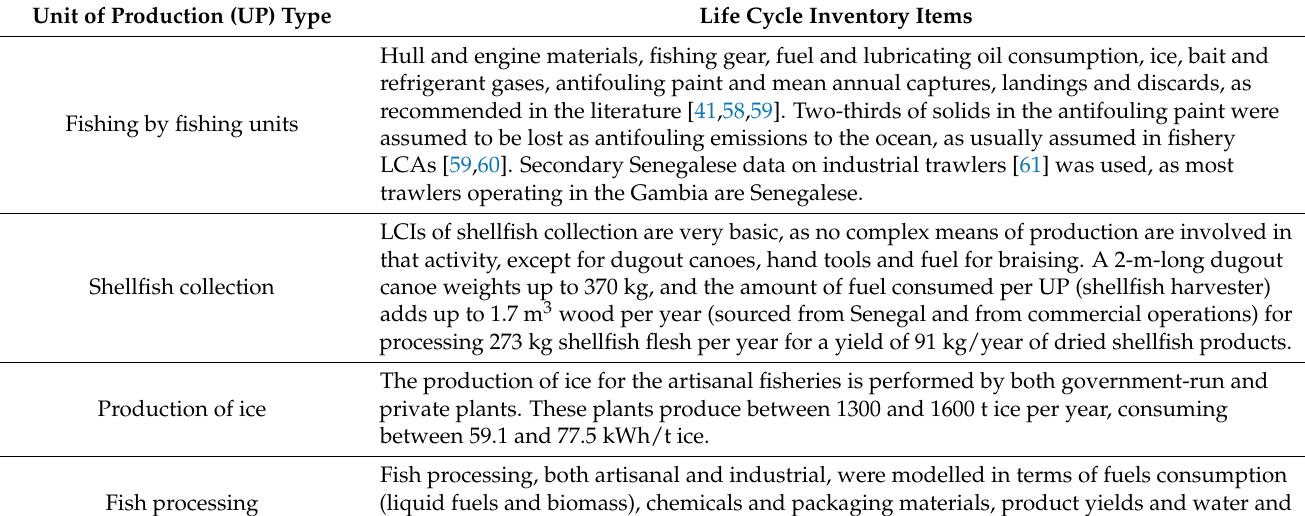
Table 1. Life cycle inventories by the type of unit of production in the Gambian fisheries value chain. Unit of Production (UP)